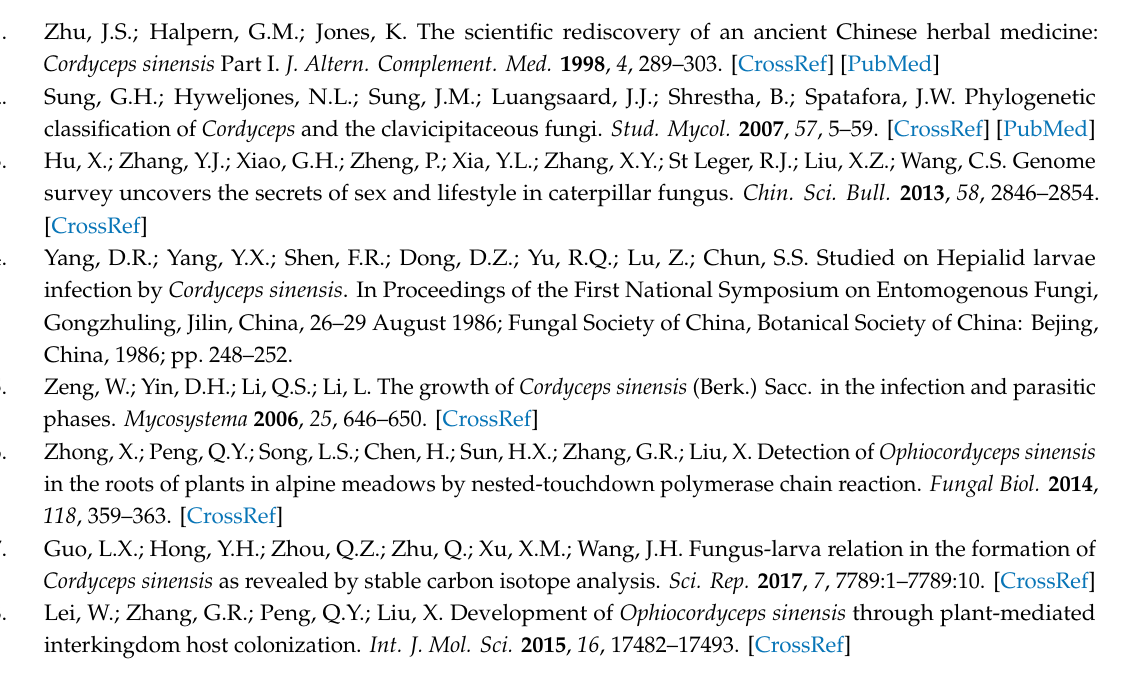
Table S1: Codes, locations, longitudes, and latitudes of the 47 O. sinensis populations used in this study, Table S2: Primer sequences for amplifying NADPH cytochrome P450 reductase genes of O. sinensis , Table S3: PCR reaction system of NADPH cytochrome P450 reductase genes of O. sinensis , Table S4: GenBank accession numbers of NADPH cytochrome P450 reductase-1 gene sequence obtained in this study, Table S5: GenBank accession numbers of NADPH cytochrome P450 reductase-2 gene sequence obtained in this study, Table S6: GenBank accession numbers of COI gene sequences of host insects of O. sinensis obtained in this study, Table S7: Haplotype correspondence of host insect COI gene, NADPH CPR-1 gene, and NADPH CPR-2 gene of O. sinensis of all